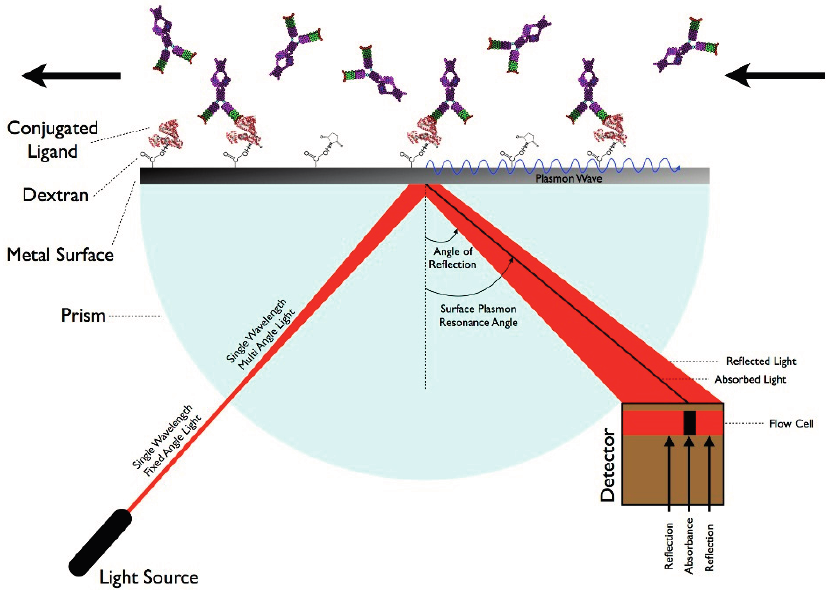
Figure 2. Surface Plasmon Resonance (SPR) [81] under license Sara